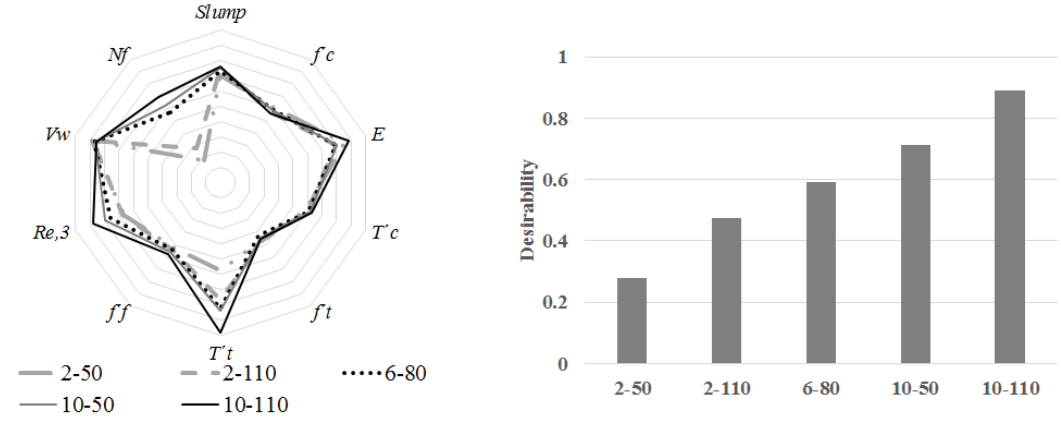
Figure 21. Comparison on the responses of recycled PET fibre reinforced concrete with different doses and aspect ratios and its statistical desirability.